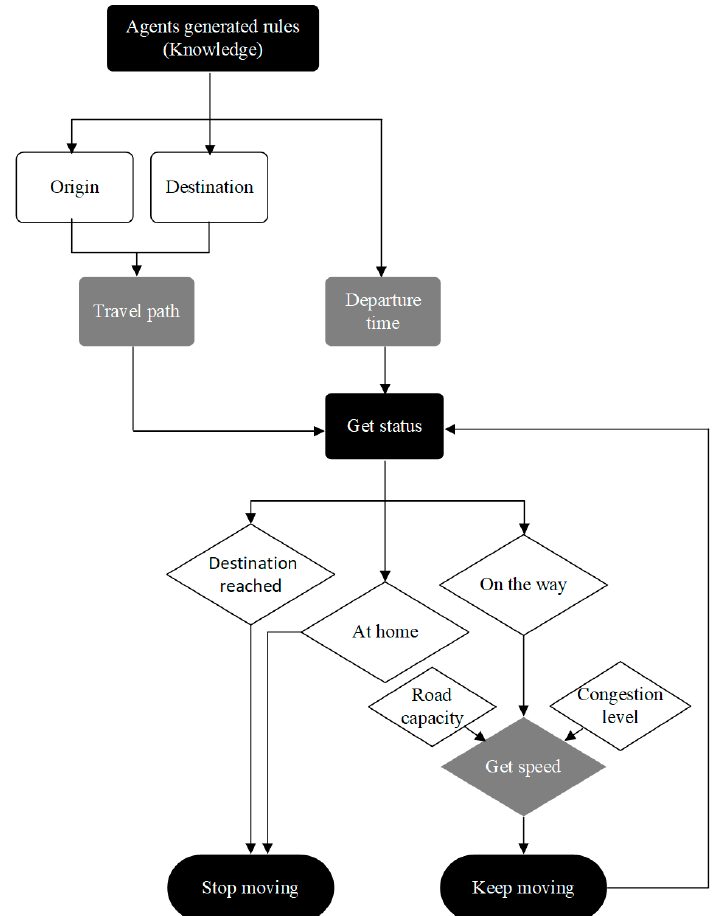
Figure 2. Diagram of rules for resident Agent behavior.